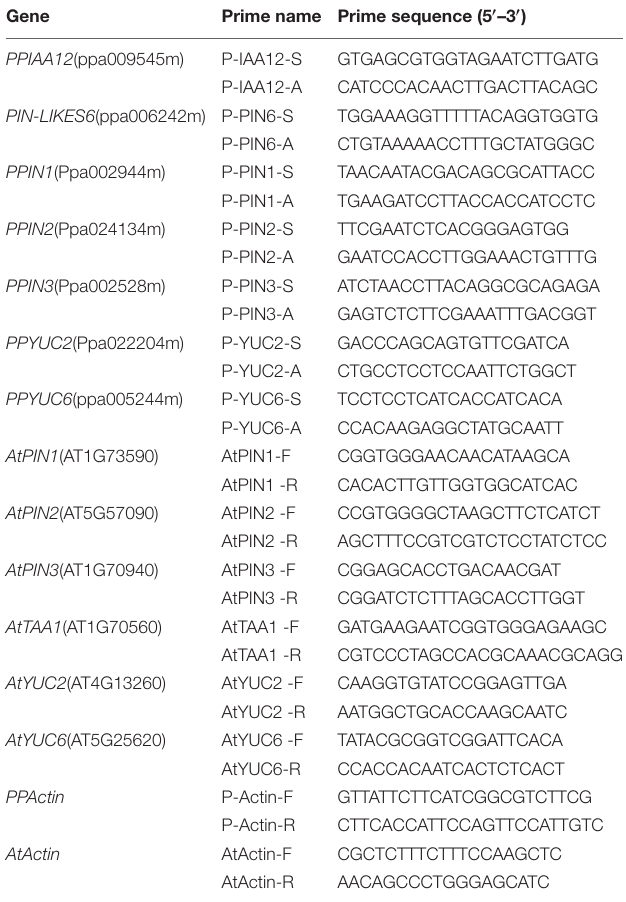
TABLE 1 | Primers used in this study.